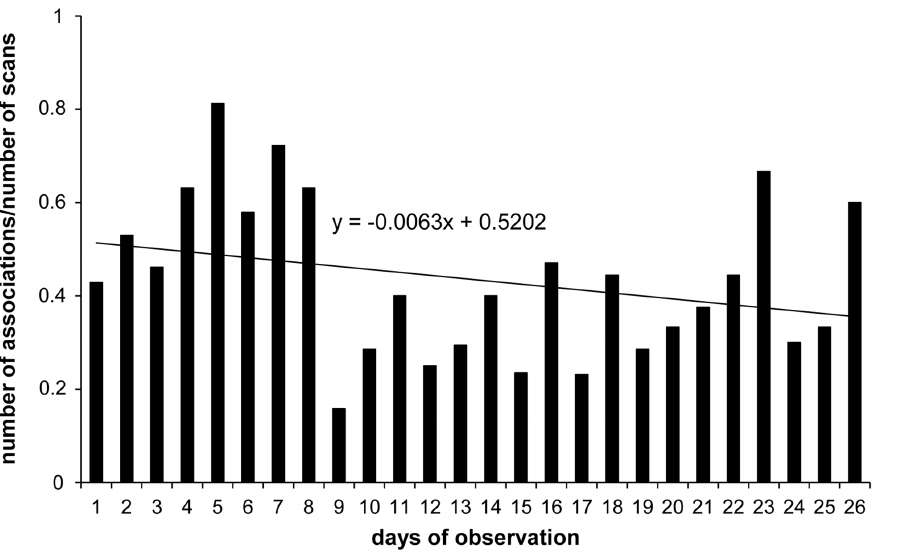
Figure 1. Number of associations observed per day corrected by the number of scans recorded per day. The solid line represents the trend followed by the distribution over time. The slope of this linear curve was not statistically different from 0, meaning that the distribution of the number of associations corrected by the number of scans did not significantly evolve over time.